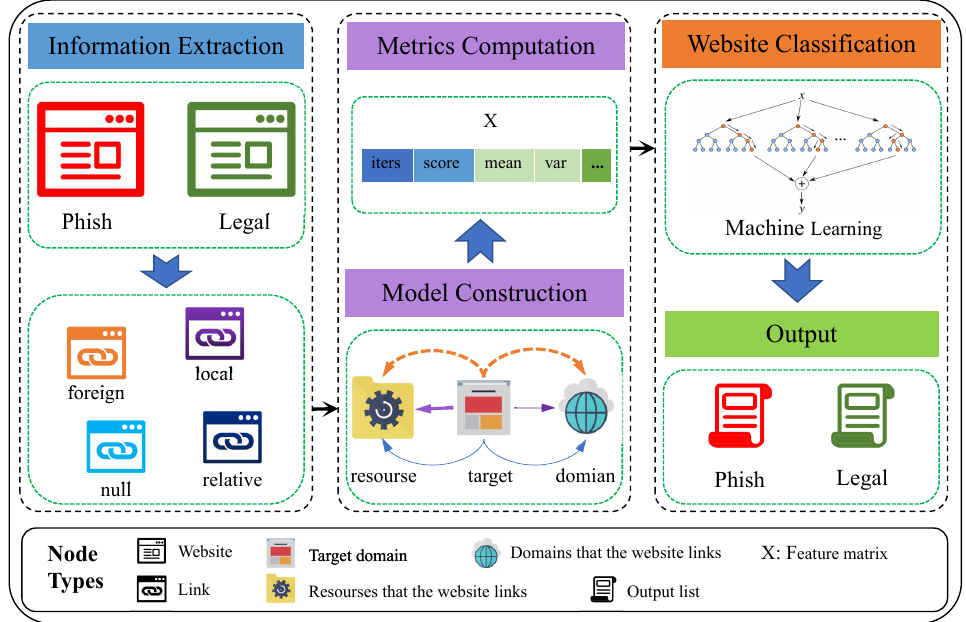
Figure 4. System architecture of